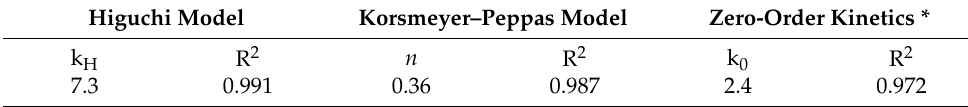
Table 2. The calculated kinetic parameters of DOX release for obtained